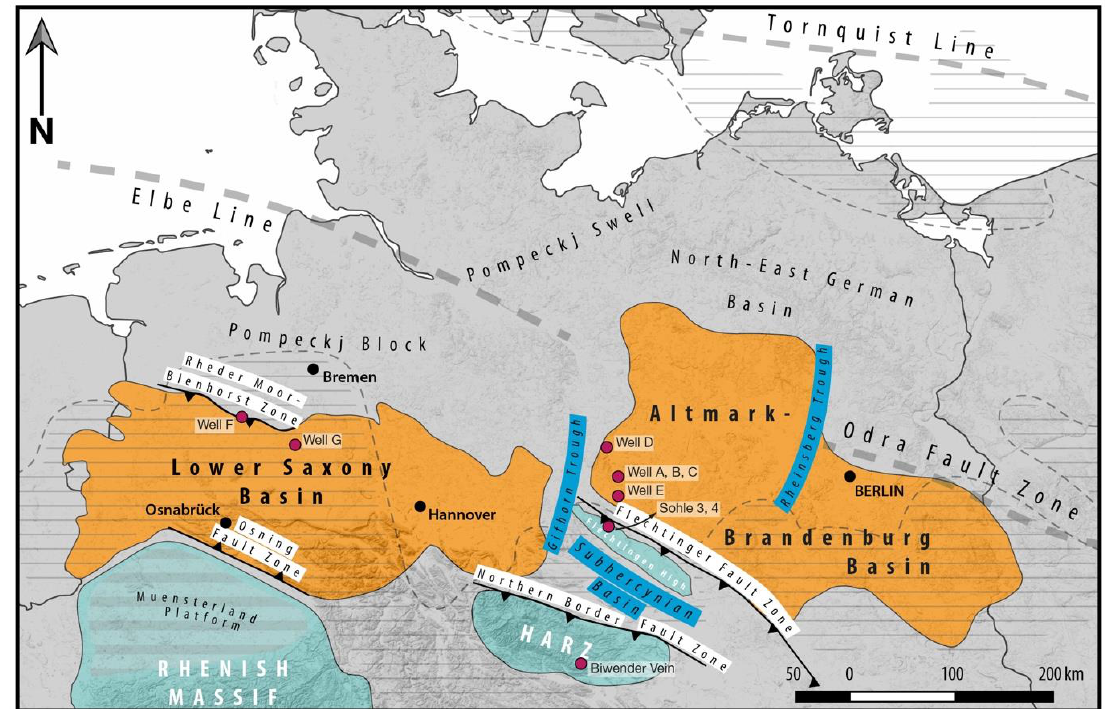
Figure 1 . Location of sampled wells/localities and major structural features of northern Germany, including the ABB, the LSB, the FCB (Flechtingen High) and the Harz. The thin unlabelled dashed line indicates the extend of the NGB with its shallow platform area (dashed area). Well names are anonymized, and locations are approximate.